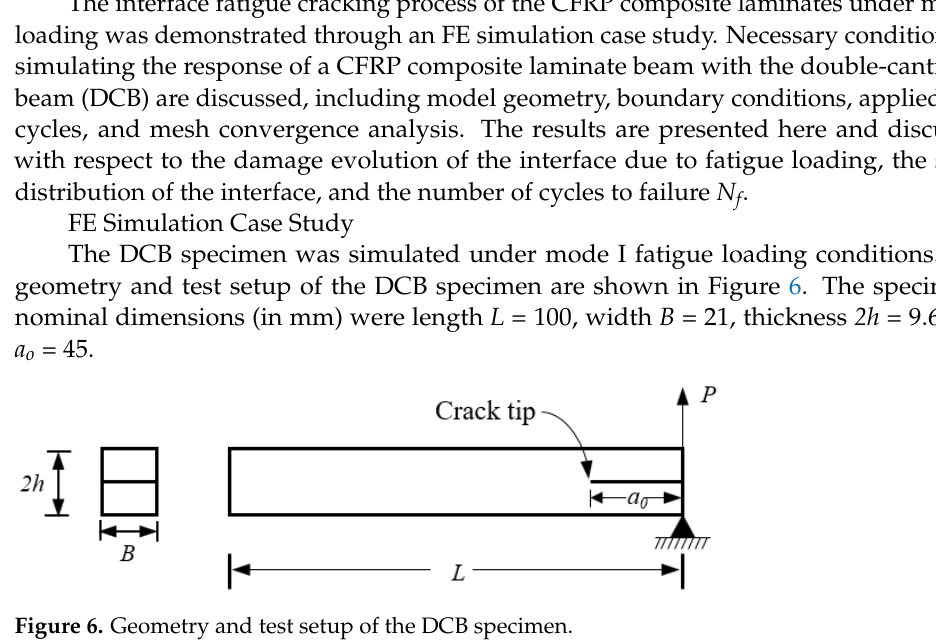
Figure 6. Geometry and test setup of the DCB specimen.